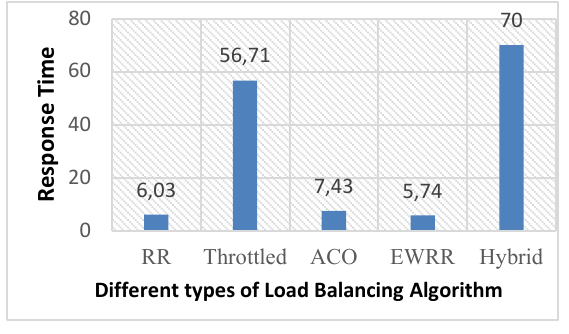
Figure 3(B) response time with different Load balancing Algorithm Using Experiment